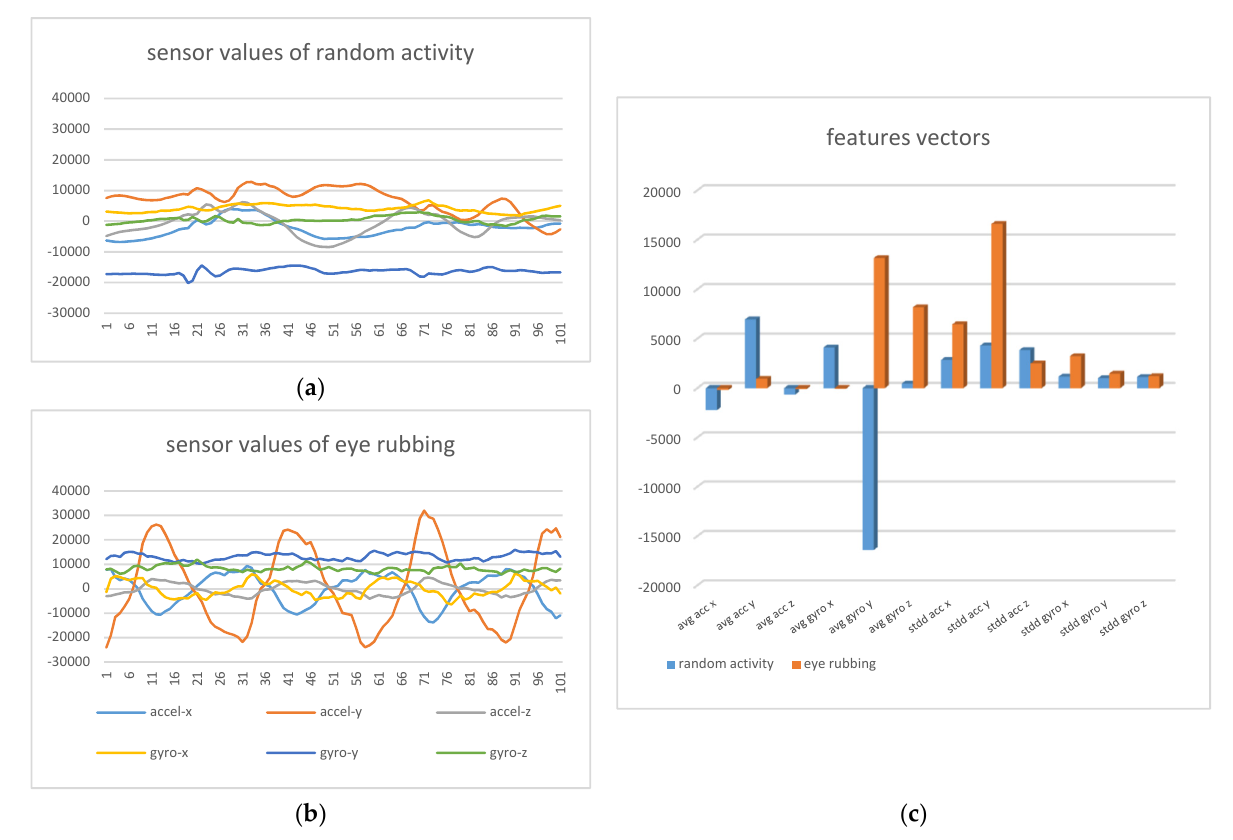
Figure 9. IMU sensor data during: ( a ) 2 s random activity; ( b ) 2 s eye rubbing; ( c ) respective feature vector values.